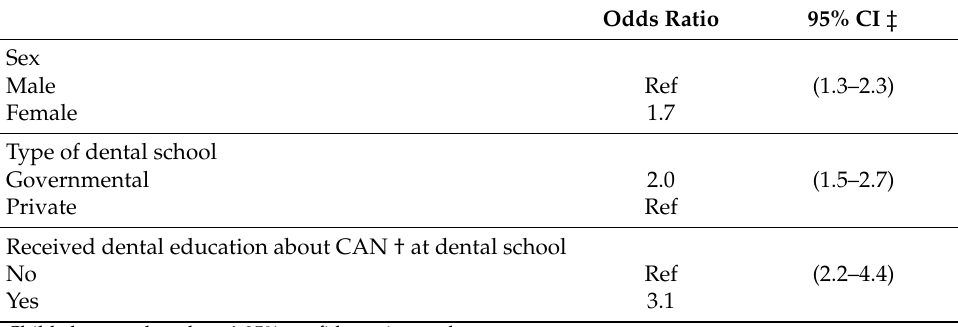
Table 3. Results of the multivariate logistic regression analysis ( n =